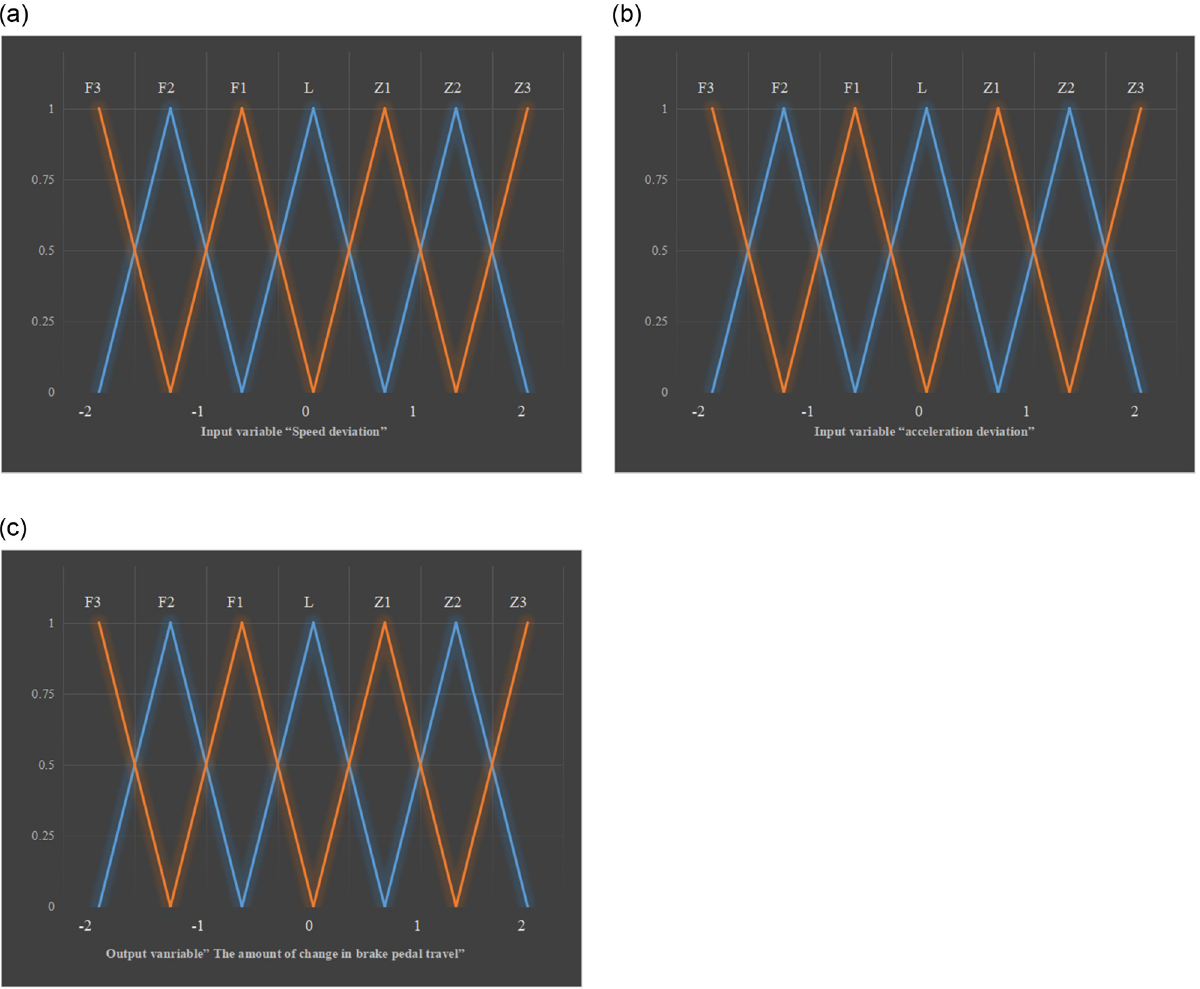
Fig 6. Membership functions of input and output variables (a) velocity deviation (b) acceleration deviation (c) brake pedal stroke change.